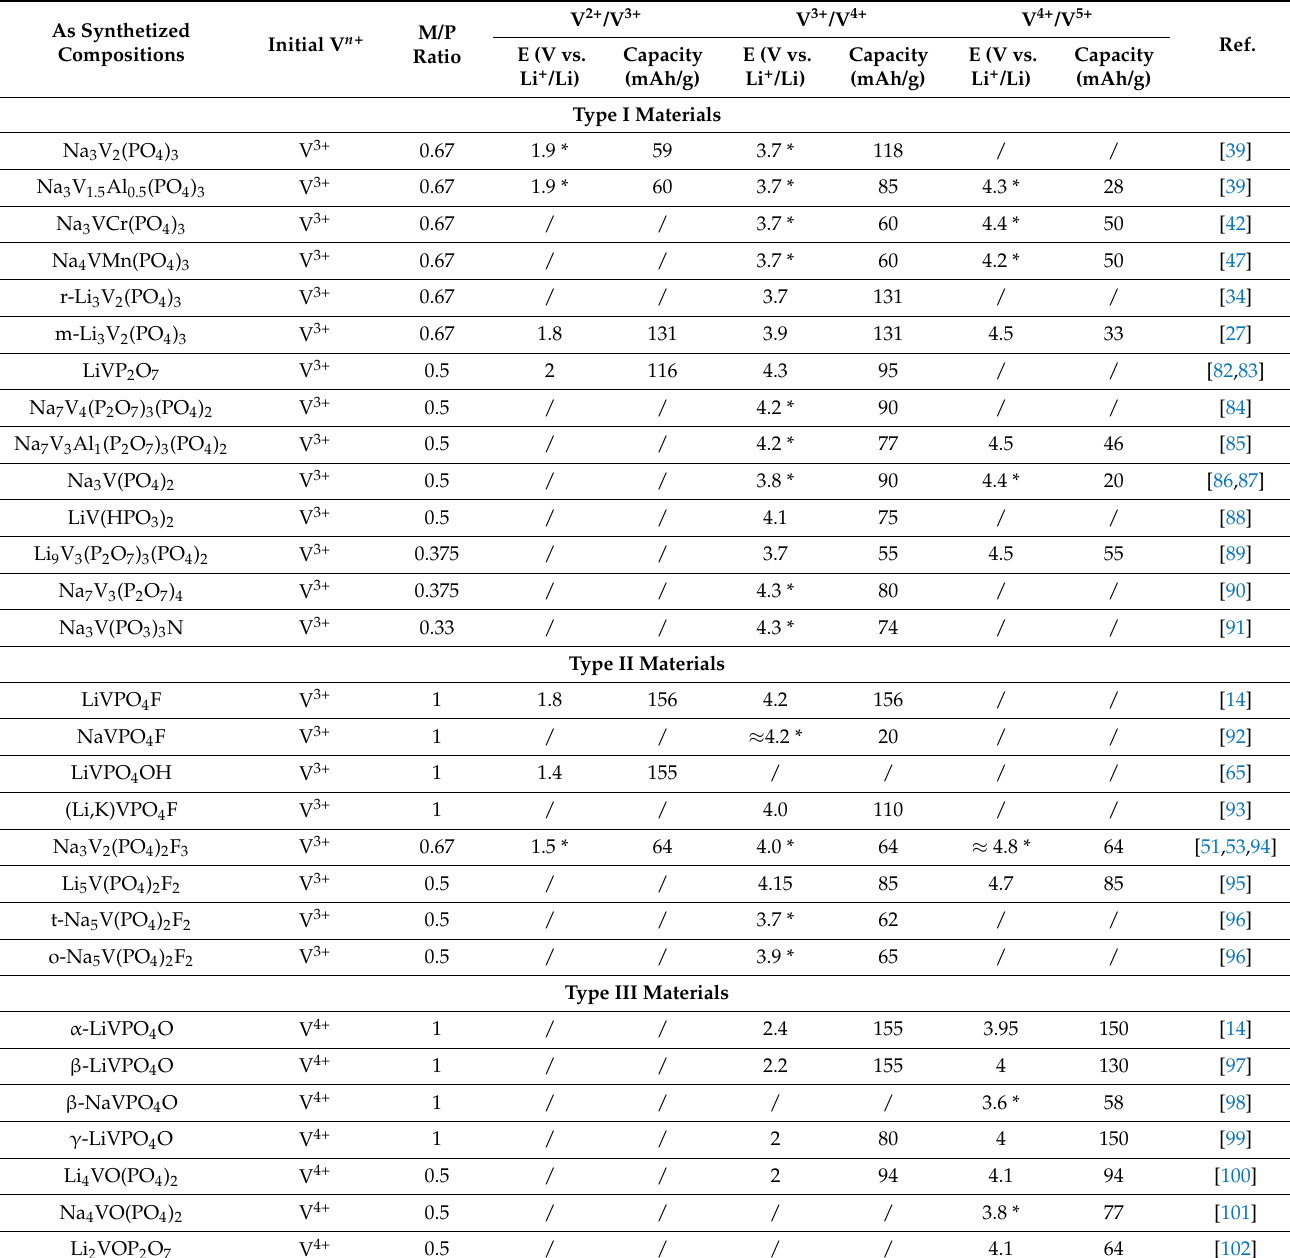
Table 1. List of the vanadium phosphate, pyro-phosphate and phosphite materials with their redox voltage and correspond- ing practical capacity based on vanadium redox. More details about the classification of these materials (Type I, II or III) are provided in the text and at the Figure